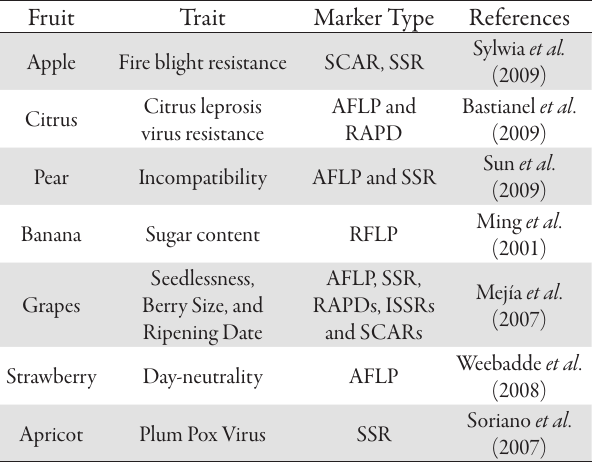
Tab. 6. Markers associated to main polygenic traits in fruit crops Fruit